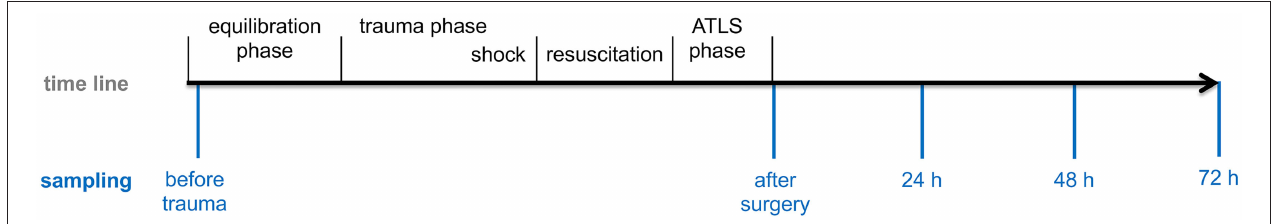
FIGURE 1 | Experimental design. Pigs underwent polytrauma consisting of lung contusion, liver laceration, tibial fracture and hemorrhagic shock followed by fluid resuscitation and fracture fixation with external fixator. Blood sampling was performed at the beginning after implementation of the central venous catheter (before trauma), after ATLS phase (after surgery) and after 24, 48 and 72 h.